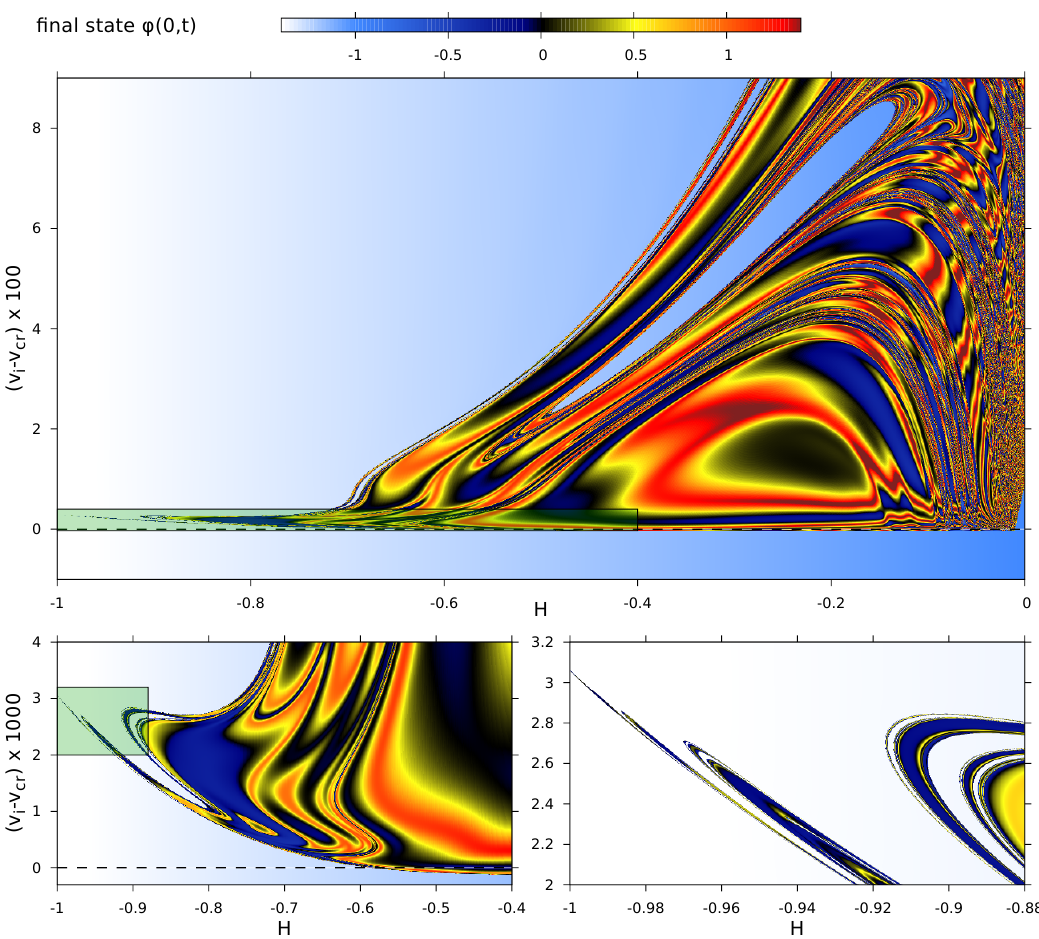
Figure 7 . Zoomed-in views of the region near the tip of the fractal tongue of (cid:12)gure 3. Note that the vertical axes show multiples of v i (cid:0) v cr , where v cr = v cr ( H ) is the theoretical upper limit of the near-elastic scattering window given by the formula